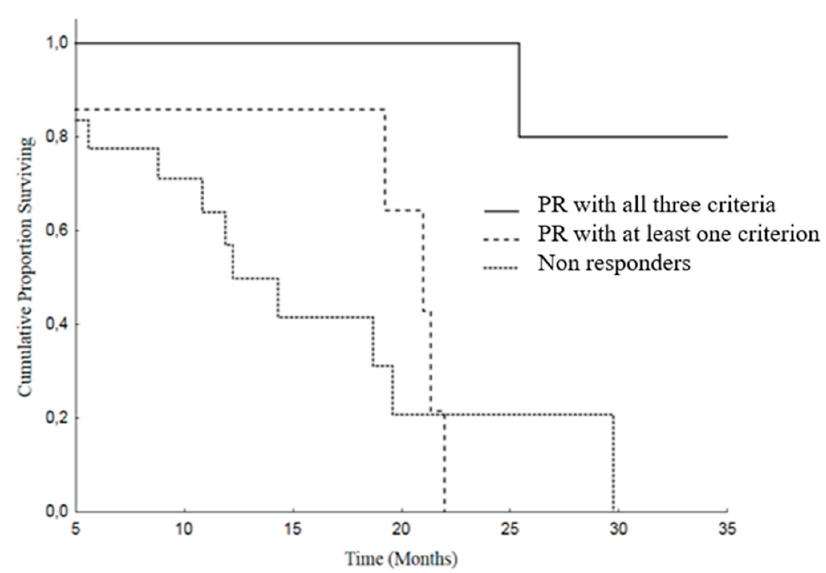
Figure 4. Overall Survival (OS) in patients with PR according to all three criteria [median 37.7 months (19.8–55.6)] versus PR in one or two criterion [median 21 months (17.3–24.6)] versus SD or PD (in all 3 criteria) [median 12.2 months (8.2–16.2)], p = 0.005.